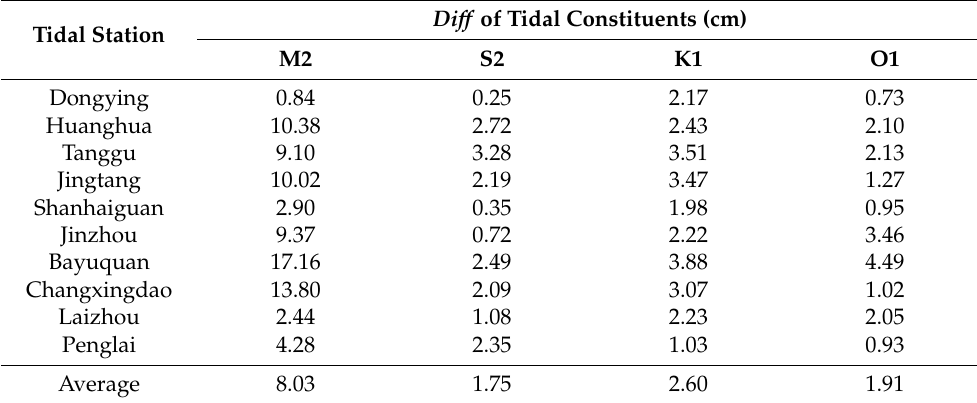
Table 1. Evaluation of the Bohai model based on the Diff values of four major tidal constituents, M2, S2, K1, and O1, at 10 tidal stations around the Bohai Sea land boundary. Diff of Tidal Constituents (cm) Tidal Station M2 S2 K1